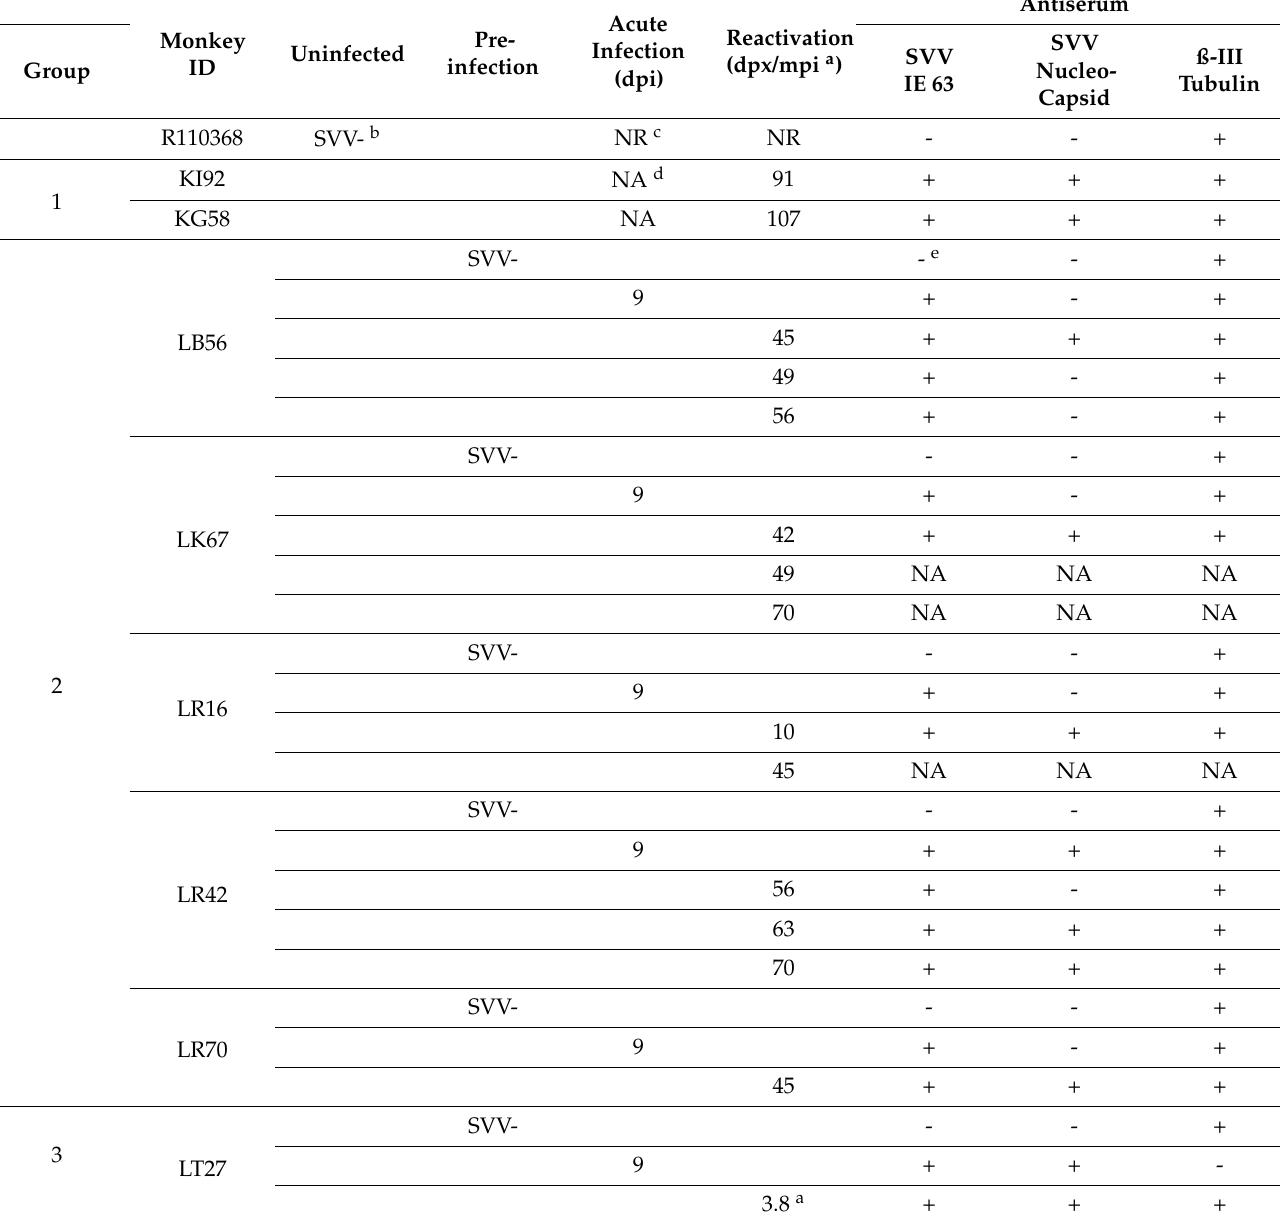
Table 7. Detection of SVV DNA and antigens in skin of rhesus macaques during varicella and zoster.